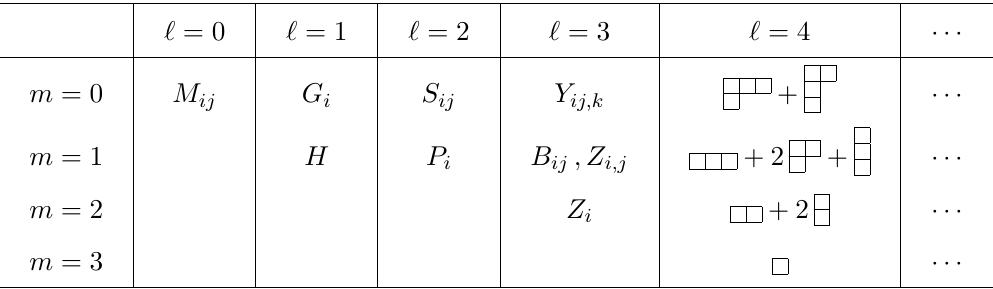
Table 1 . The free Lie algebra extension of the magnetic Galilei Maxwell algebra, generated by G i and H (together with the rotation generators M ij ) One of the two Young tableaux with two boxes in one column at ( ‘; m ) = (4 ; 2) corresponds to the magnetic (cid:12)eld generator Z ij